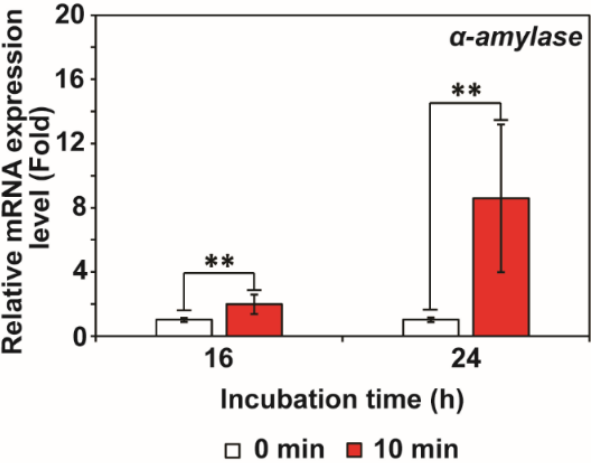
Figure 3. Transcription of α-amylase in fungal hyphae after exposure to RF-EMF. Level of mRNA in fungal cells was measured at 16 and 24 h after fungal spores were unexposed (control) and exposed to RF-EMF (2 GHz, 0.01 W) for 10 min. Each value represents the mean of nine replicate measurements. The experiment was repeated three times, each with three replicate measurements: ** p < 0.01.